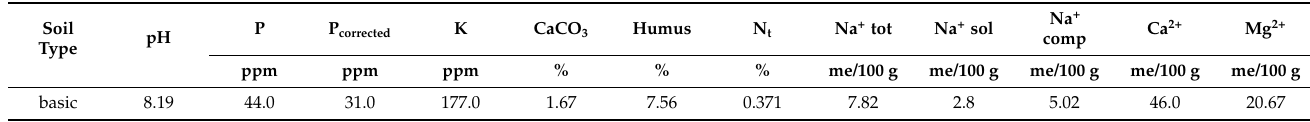
Table 3. Basic field results.